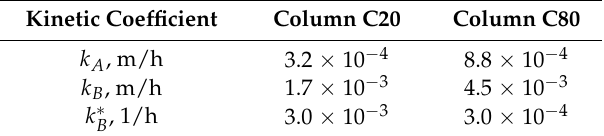
Table 5. Fitted kinetic parameters obtained for both column